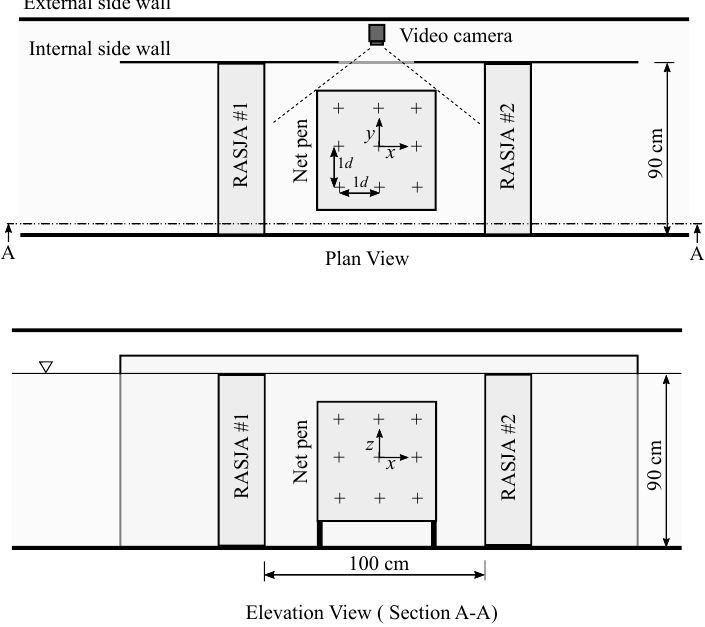
Figure 1. Schematic of the dual RASJA test facility showing the window in the internal side wall for underwater surveillance of fish during testing. Locations of the velocity survey are indicated with cross-hairs with a separation of 1 d .